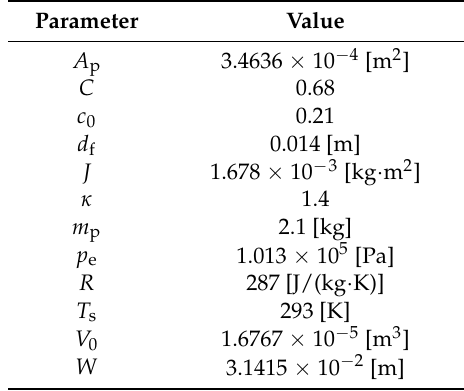
Table 3. Constants in the model parameters.